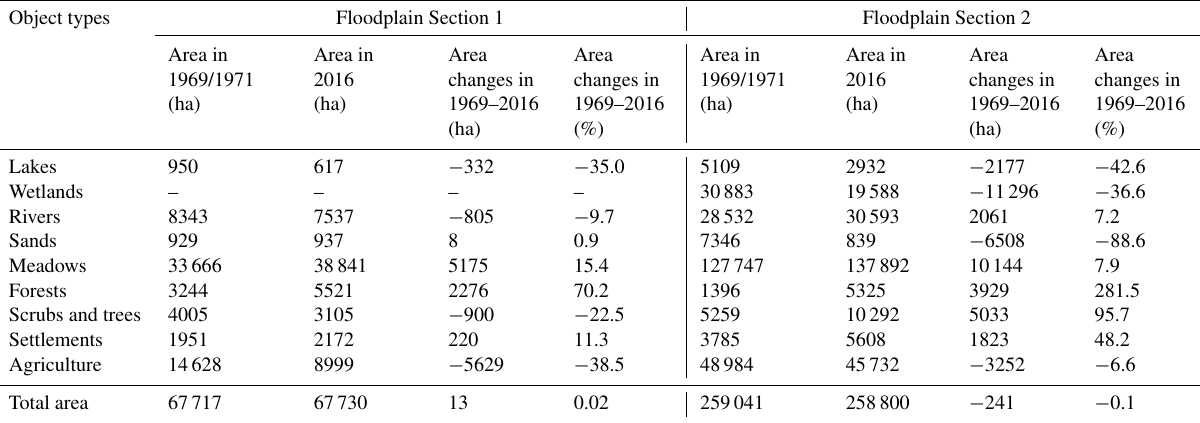
Table 1. Land cover in the study area for the time period 1969–2016. Object